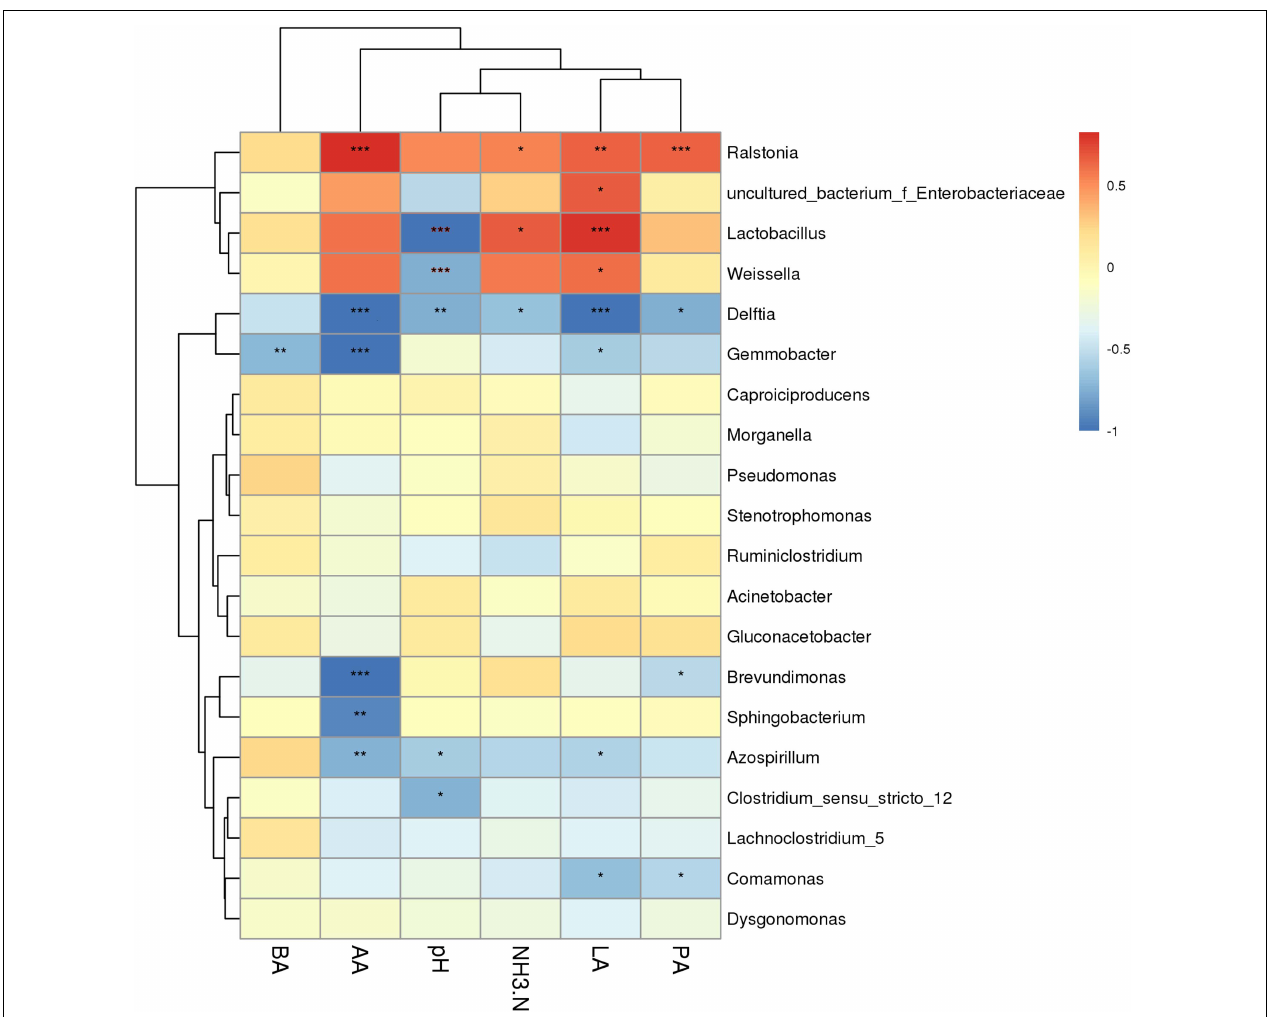
FIGURE 5 | Correlation of the bacterial community and silage fermentation (CK, control; L, Lactobacillus plantarum ; CA, Citric acid; CAL, Citric acid + Lactobacillus plantarum ; LA, Lactic acid; AA, Acetic acid; PA, Propionic acid; BA, Butyric acid; NH 3 -N, Ammonia-N). * P < 0.05, ** P < 0.01 and *** P <